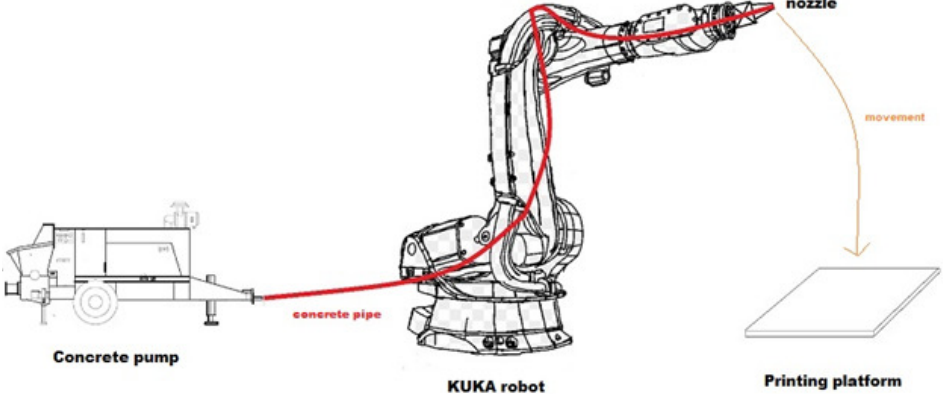
Figure 2. Connection between the concrete pump and the printing robot.